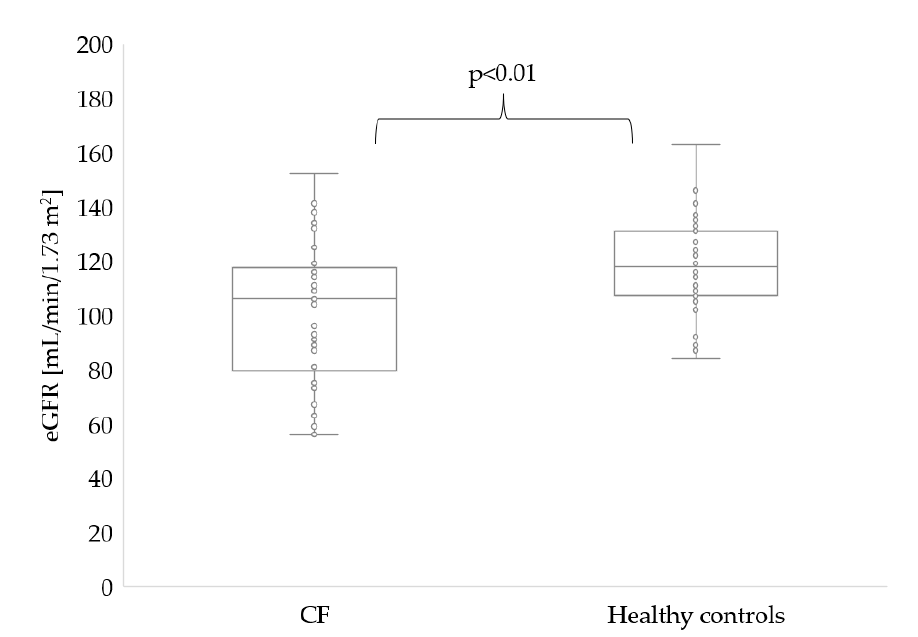
Figure 2. eGFR CKD-EPI in patients with CF and healthy controls. There were no statistical differences in sCr levels between patients with CF and healthy controls ( p = 0.576 for participants under 18 and p = 0.196 for adults). However, in 10 CF patients under 18 years of age, sCr levels were above normal. Blood urea level was similar in both groups (27 vs. 25, p = 0.097). However, in two patients with CF, the urea level was below normal, while seven patients with CF had urea levels above normal. No significant differences ( p = 0.766) were noted in uNGAL concentrations in CF and healthy